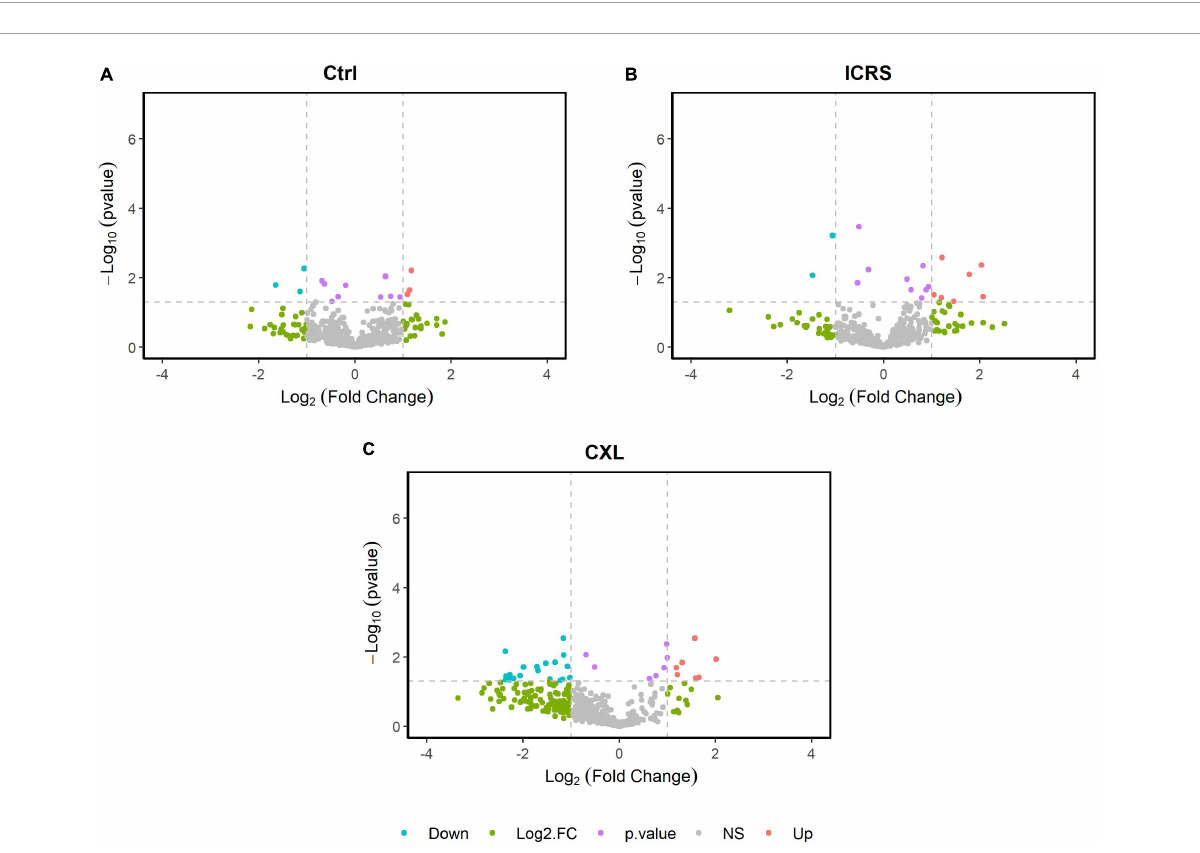
changes produced between the two time points (basal and 18 months’ post-surgery) were also analyzed for each of the two surgical approaches ( Figure 3 ). At 18 months’ post-surgery, up-